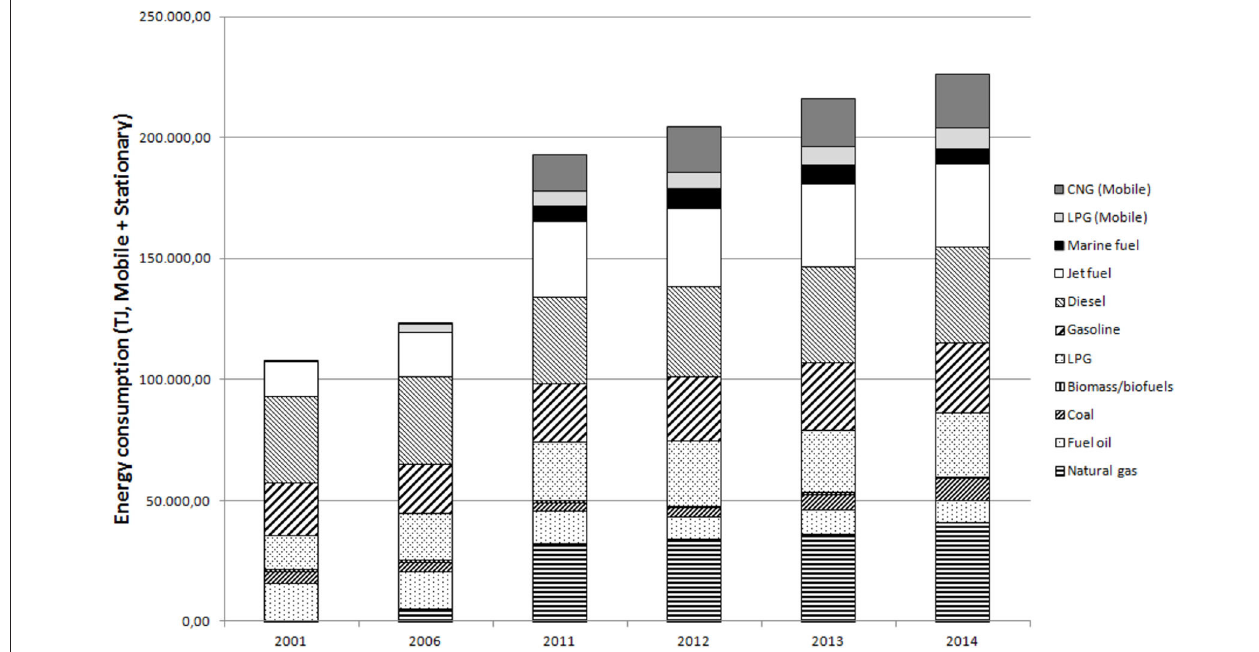
FIGURE 4 | Temporal evolution of total energy consumption showing different fuels.